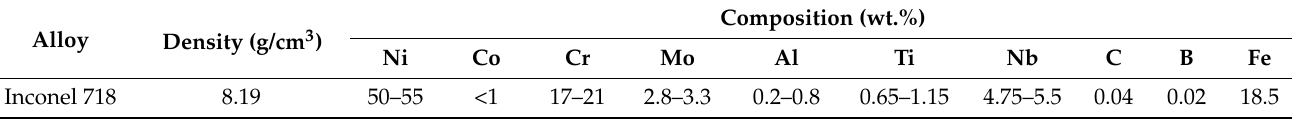
Table 3. Chemical compositions of Inconel